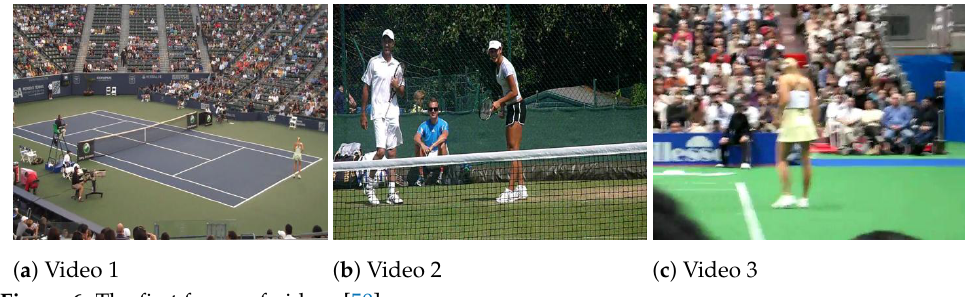
(cid:107)W ( 1/2 ) ( (cid:98) T −T ) (cid:107) F . (cid:26) (cid:107)W ( 1/2 ) (cid:107) F